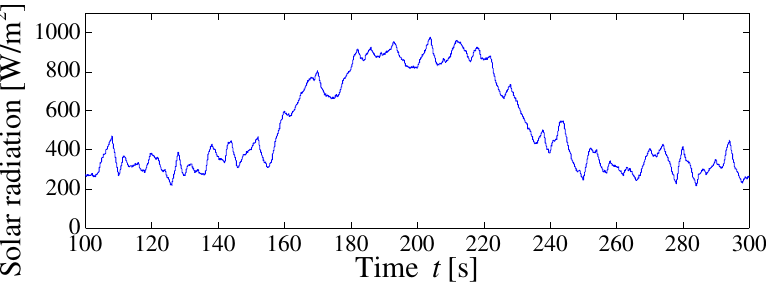
Figure 13. Solar radiation.